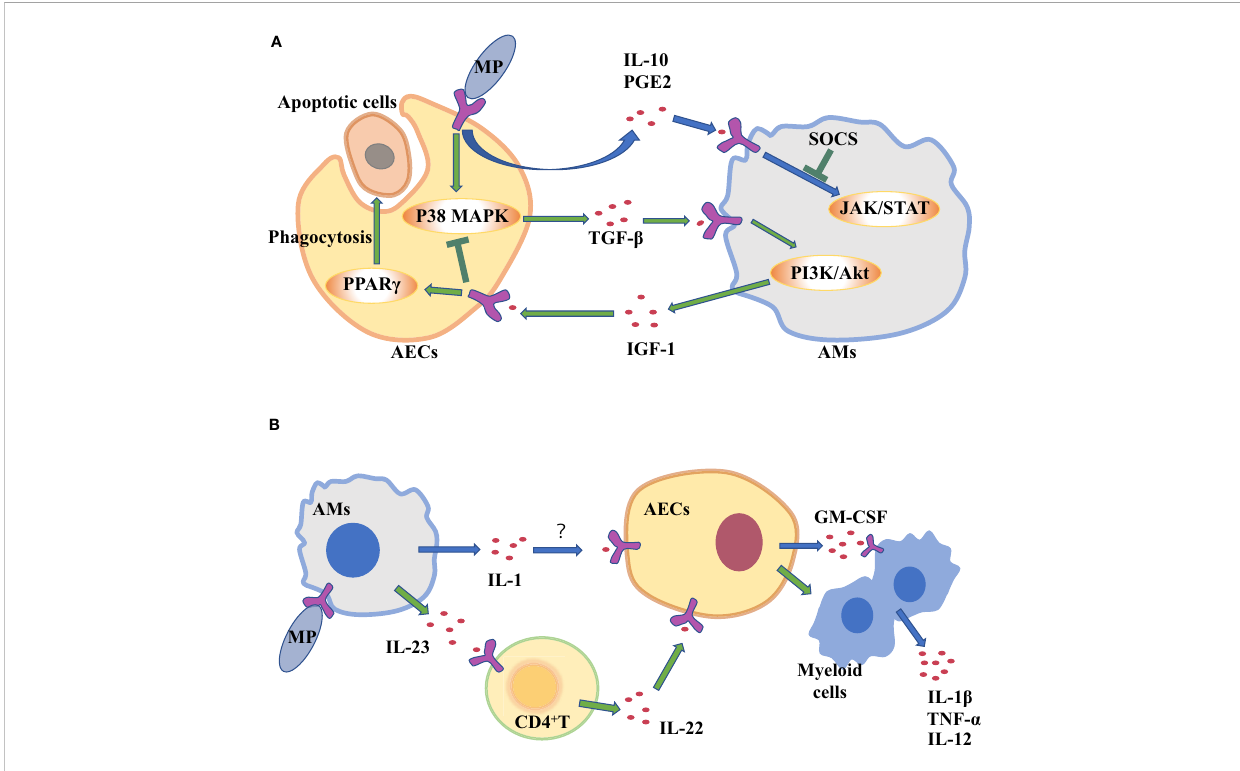
FIGURE 2 Alveolar macrophages (AMs) and alveolar epithelial cells (AECs) communicate with each other through cytokines to clear Mycoplasma pneumoniae (MP). (A) AECs attacked by MP secrete cytokines to regulate in fl ammation in AM. (B) Cytokine secretion by MP-challenged AMs ampli fi es in fl ammation in